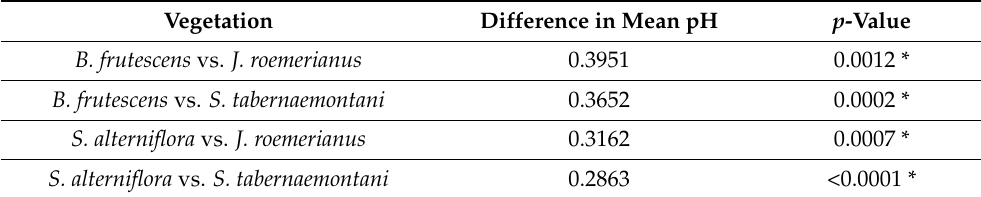
Table 3. Results from Tukey HSD for mean pH of species